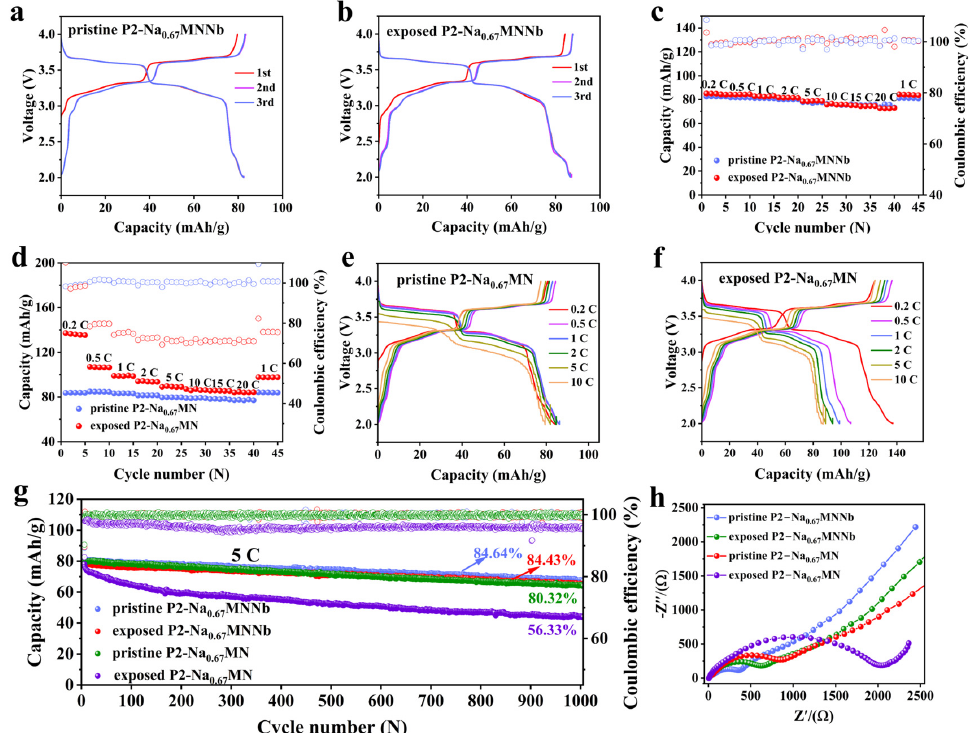
Figure 5. ( a , b ) Galvanostatic charge/discharge voltage profiles of the pristine P2-Na 0.67 MNNb and exposed P2-Na 0.67 MNNb at the first three cycles in the voltage range of 2–4 V, respectively (exposed P2-Na 0.67 MNNb refers to exposing pristine P2-Na 0.67 MNNb to RH93% humid environment for 20 days). ( c ) Rate capability of pristine P2-Na 0.67 MNNb and exposed P2-Na 0.67 MNNb. ( d ) Rate capability of pristine P2-Na 0.67 MN and exposed P2-Na 0.67 MN. Charge and discharge curves of ( e ) pristine P2-Na 0.67 MN and ( f ) exposed P2-Na 0.67 MN at di ff erent current densities. ( g ) Electrochemical cycling performance of pristine P2-Na 0.67 MN, exposed P2-Na 0.67 MN, pristine P2-Na 0.67 MNNb and exposed P2-Na 0.67 MNNb at a rate of 5 C for 1000 cycles. ( h ) Nyquist plot of the coin cells that based on pristine P2-Na 0.67 MN, exposed P2-Na 0.67 MN, pristine P2-Na 0.67 MNNb and exposed P2-Na 0.67 MNNb electrode materials after 1000 cycles at a rate of 5 C.